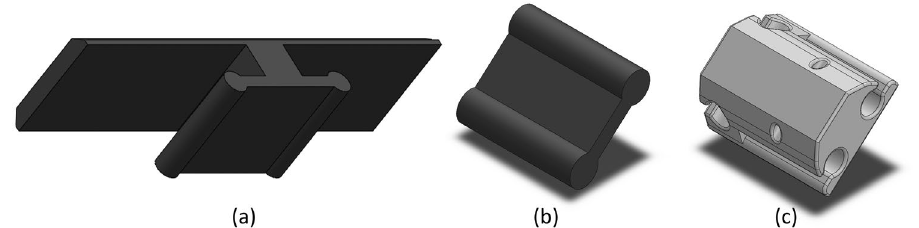
Fig. 3 Designed modules: a flexible scoop joint; b flexible finger joint; c rigid